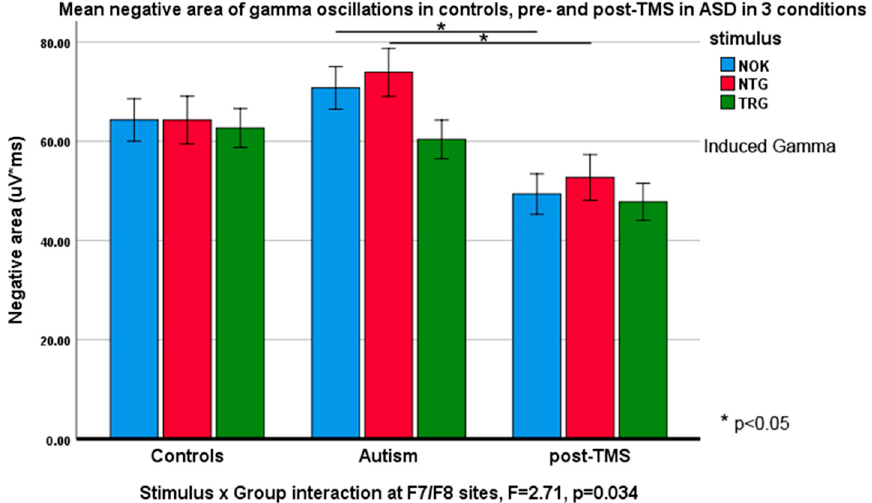
Figure 5. Negative slope area (Mean ± SE) of induced gamma oscillations in response to target Kanizsa (TRG), non-target Kanizsa (NTG) and non-Kanizsa (NOK) stimuli in typical children, children with ASD pre- and post-TMS treatment. Stimulus (TRG, NTG, NOK) × Group (CNT, ASD pre-, ASD post-TMS) interaction was significant at the inferior frontal sites (F7, F8). Note decrease of areas in response to non-target items post-TMS.